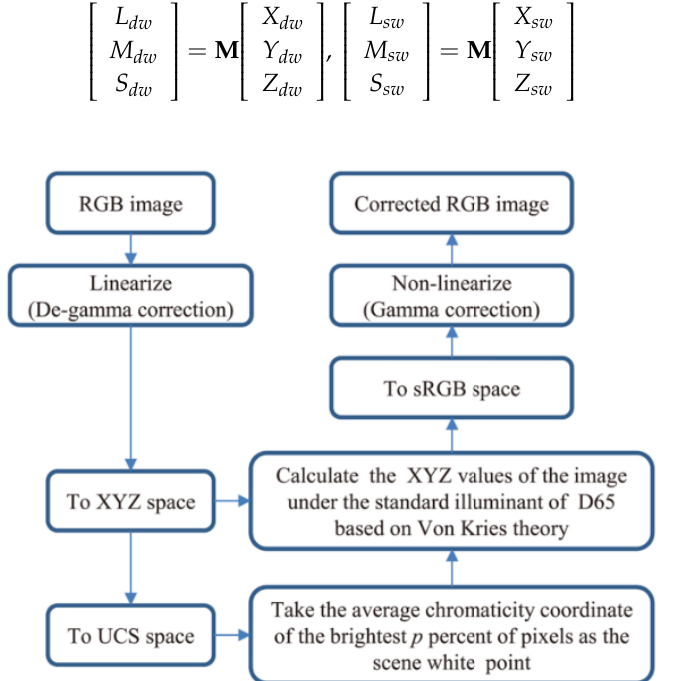
Figure 2. Color correction flow.